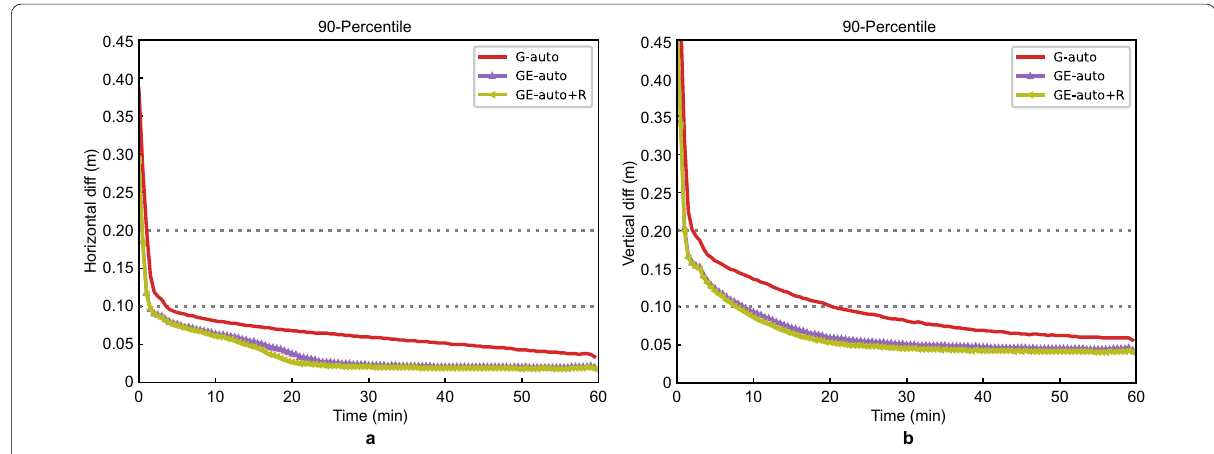
Fig. 7 The time series of the 90th percentile of horizontal ( a ) and vertical ( b ) positioning errors for three groups of PPP-RTK solutions with the proposed dynamic ionosphere stochastic